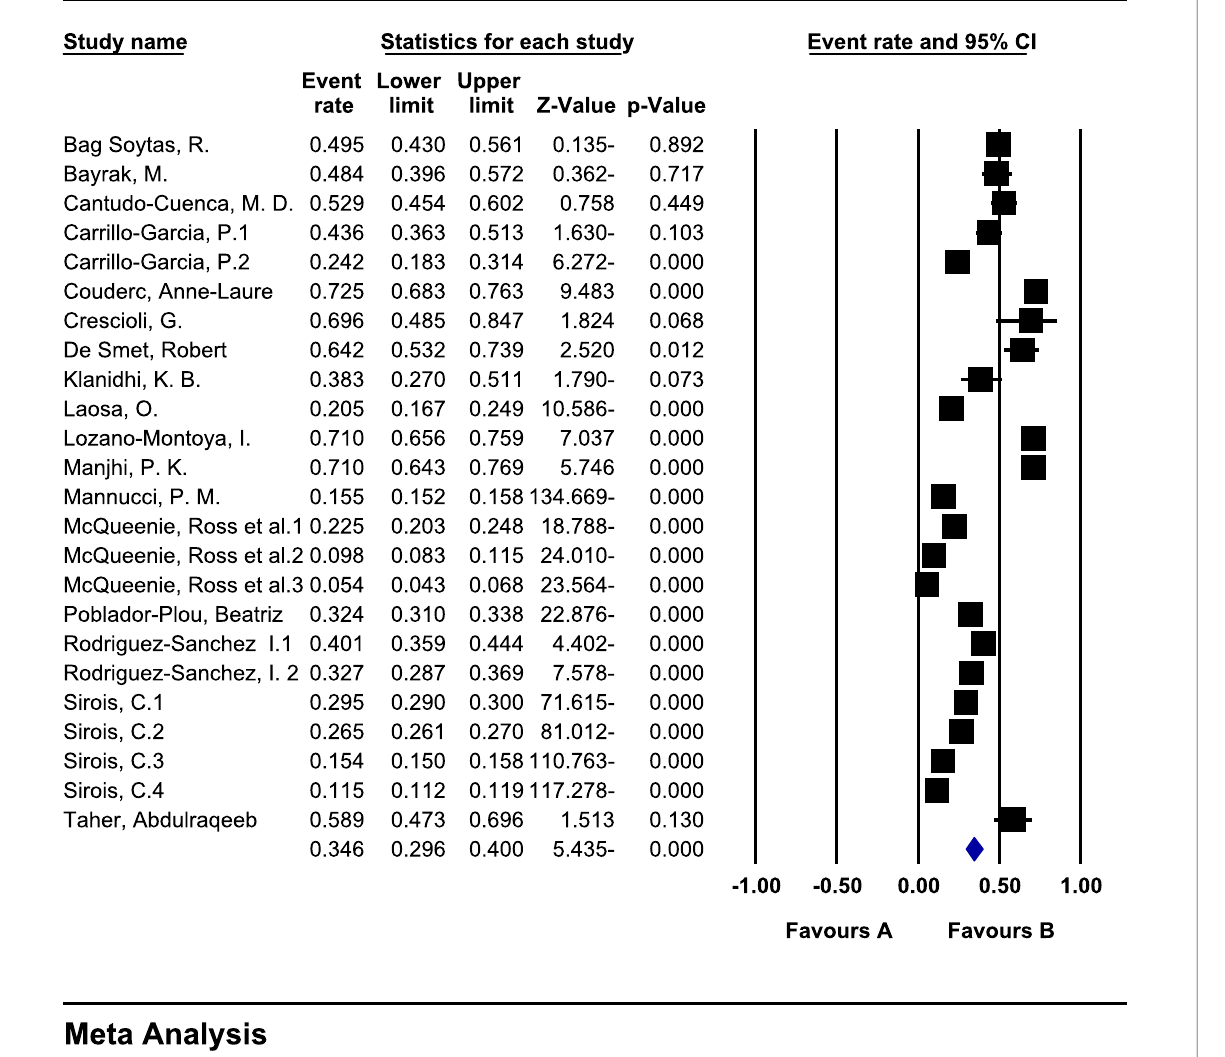
Fig. 3 Forest plot and general meta‑analysis of the results of studies based on random effects